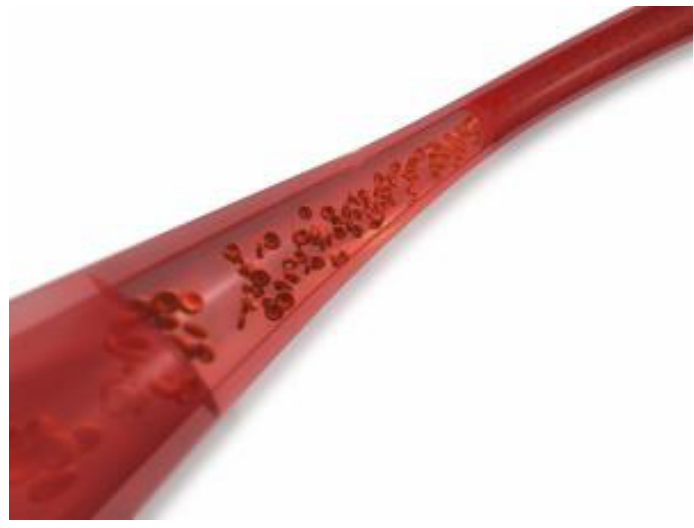
Figure 1. Blood flow in an